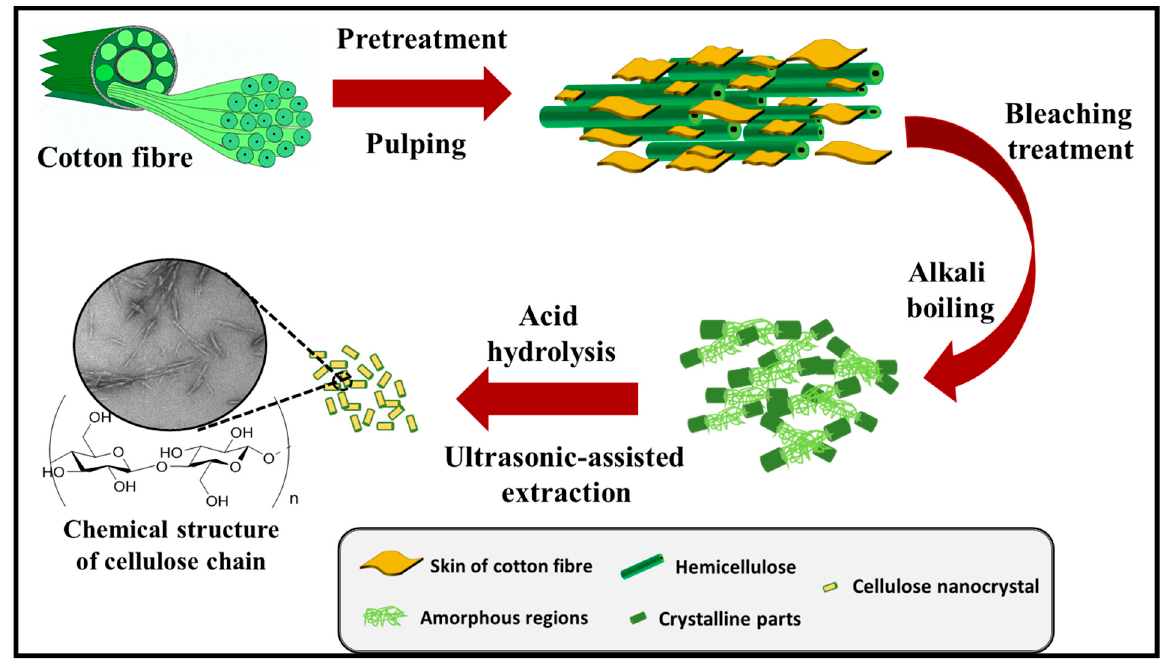
Figure 10. Schematic of nanocrystalline cellulose extraction from the cellulose chain using acid hydrolysis for the removal of the amorphous region [4].